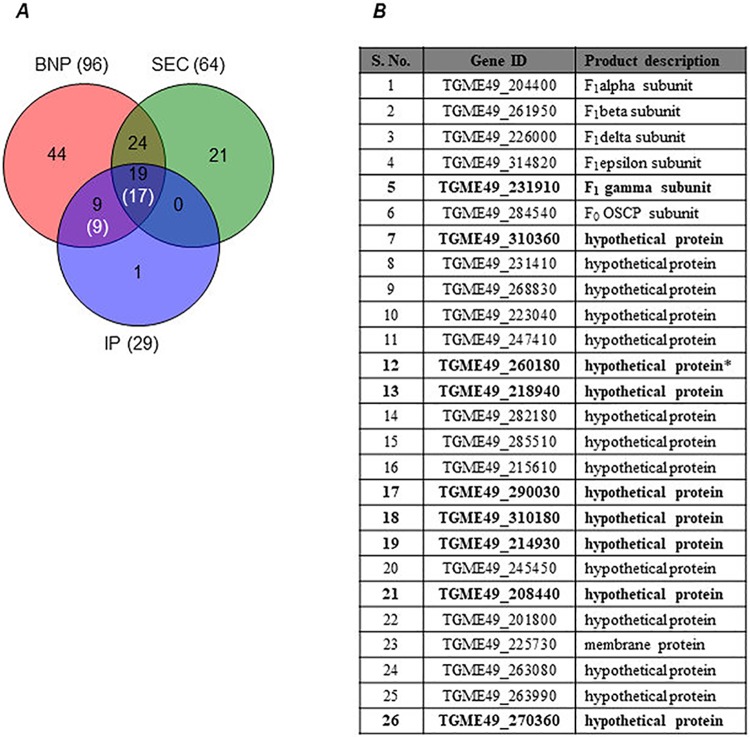
Identification of novel T. gondii F-type ATP synthase subunits from LC-MS/MS analysis.(A) The Venn diagram shows shared identification of proteins following BNP, SEC, and IP sample preparation. Total number of proteins identified in each technique is given within brackets outside the Venn diagram. The numbers shown in white font and within brackets are the final set of proteins assigned as subunit components of T. gondii F-type ATP synthase. (B) List of all genes identified in this work by mass spectrometry analysis. Gene ID and product description details are from Toxodb.org (release 36). The entries shown in bold indicate that the protein was detected with high confidence from only BNP and IP samples. Asterisk indicates that the corresponding peptides were detected in only one of the replicate runs for SEC sample. BNP data are a combination of experiments done with both TgATPβ-YFP-HA–and TgATPOSCP-YFP-HA–expressing transgenic parasites. SEC and IP data are from TgATPβ-YFP-HA and TgATPOSCP-YFP-HA expressing transgenic parasites, respectively. BNP, blue native PAGE; IP, immunoprecipitation; LC-MS/MS, liquid chromatography–tandem mass spectrometry; OSCP, oligomycin sensitivity–conferring protein; SEC, size exclusion chromatography; TgATPβ, T. gondii ATP synthase β subunit; TgATPOSCP, T. gondii ATP synthase OSCP subunit; YFP-HA, yellow fluorescent protein plus hemagglutinin.